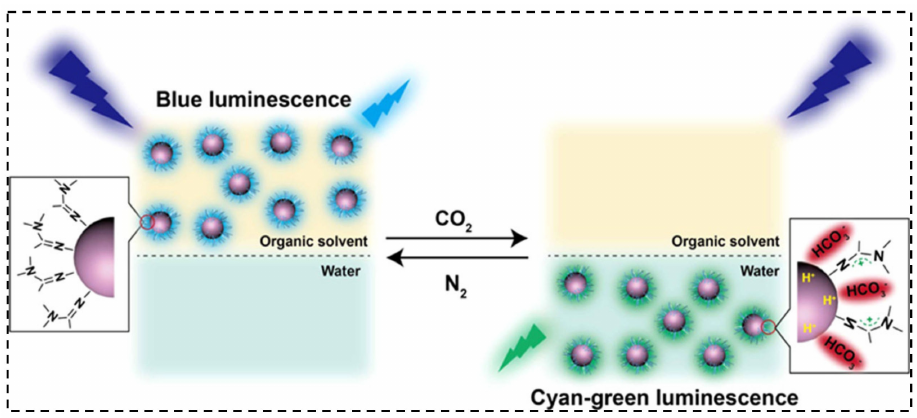
Figure 5. The reversible phase transfer of the amidine-modified CDs and the reversible luminescence change between blue and cyan-green luminescence change in the presence of CO 2 and N 2 [131] (Reproduced with